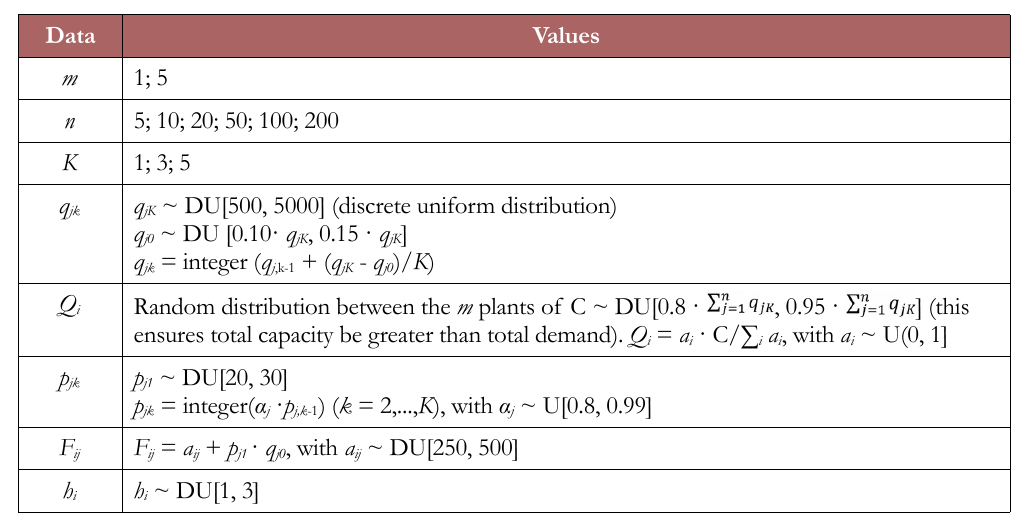
Table 2. Data set